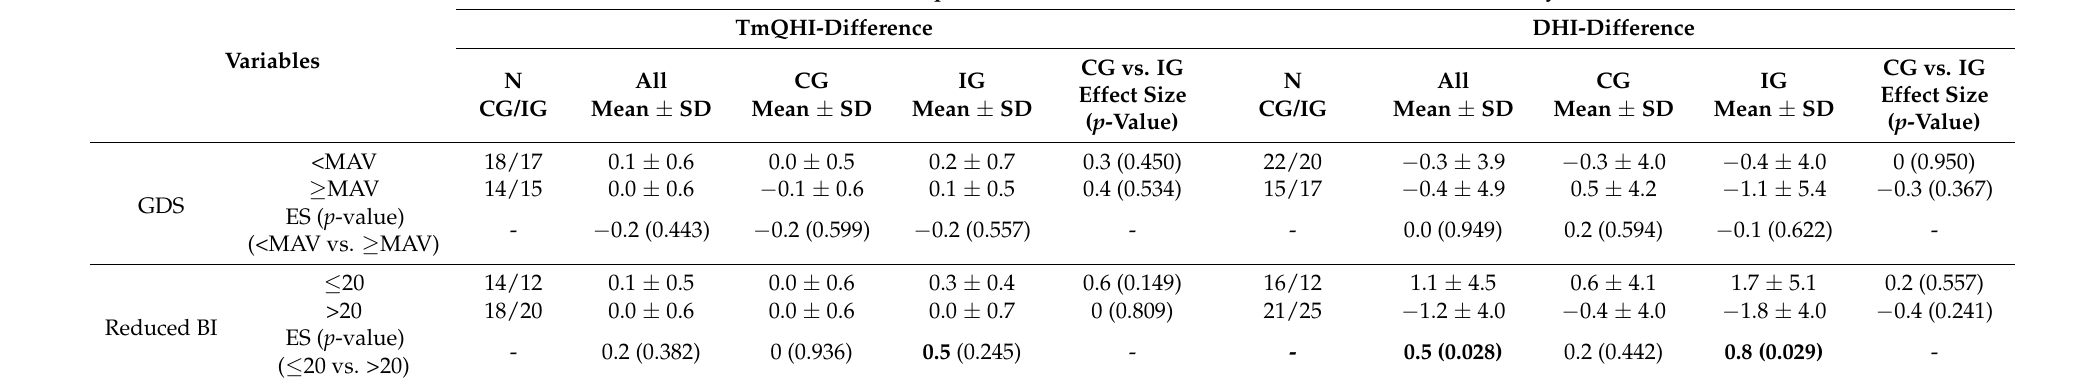
Plaque Reduction between T0 and T1a (Mean Duration, 12.4 Days)